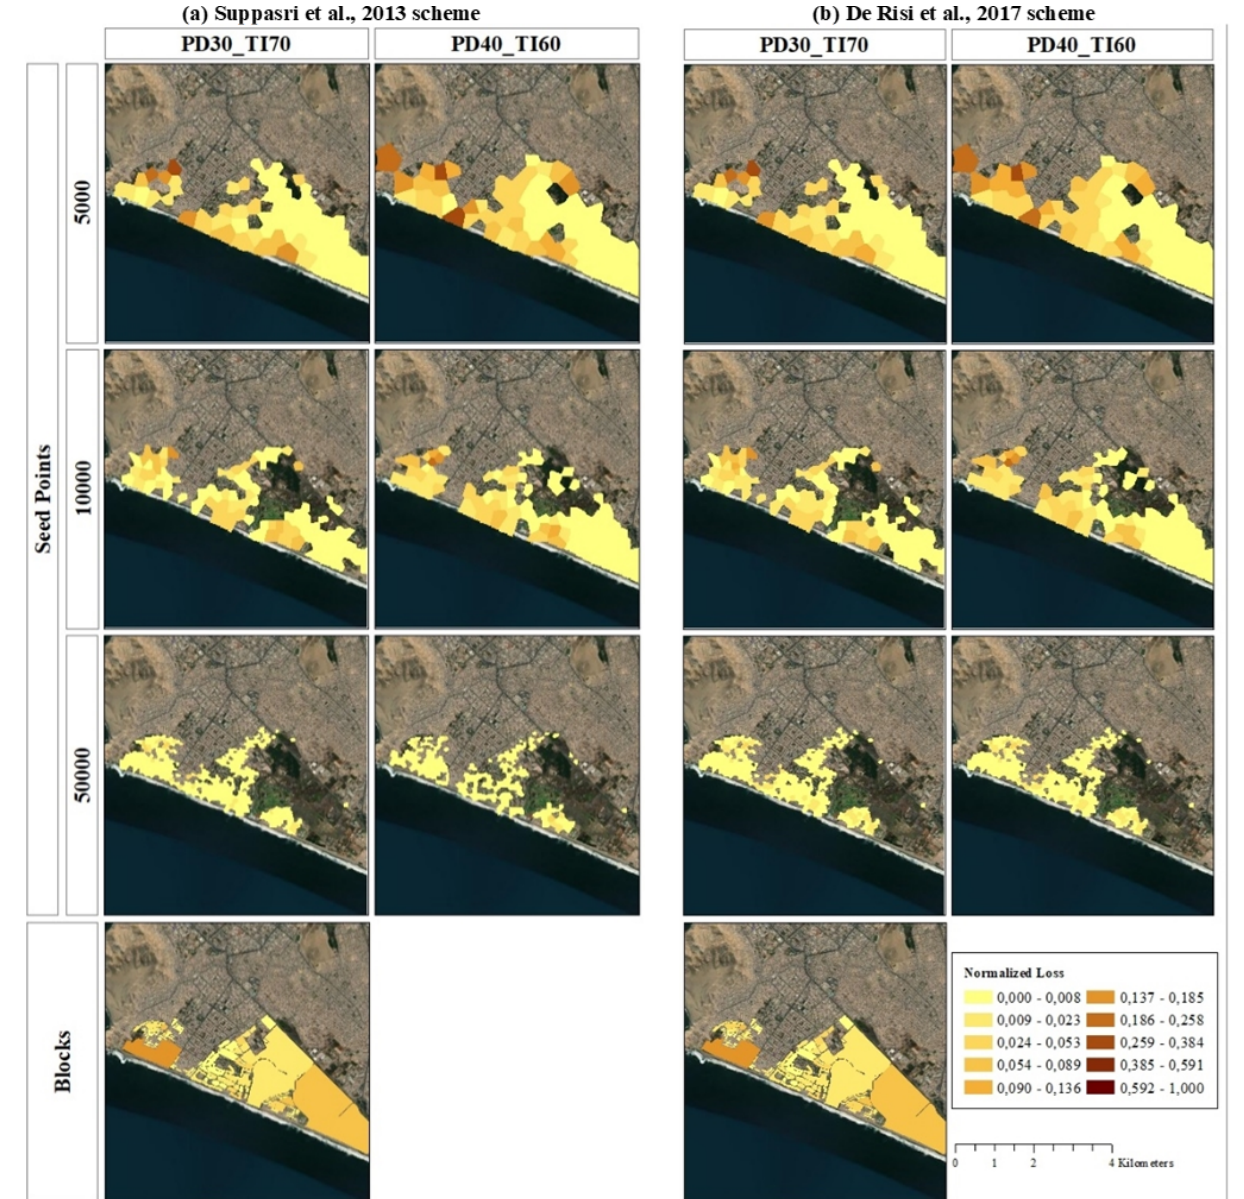
Figure 18. Spatial distribution of tsunami-induced normalised losses ( M w 8.8 scenario) for the Chorrillos district (Lima) using two tsunami reference schemes: (a) Suppasri et al. (2013) and (b) De Risi et al. (2017). Map data: © Google Earth